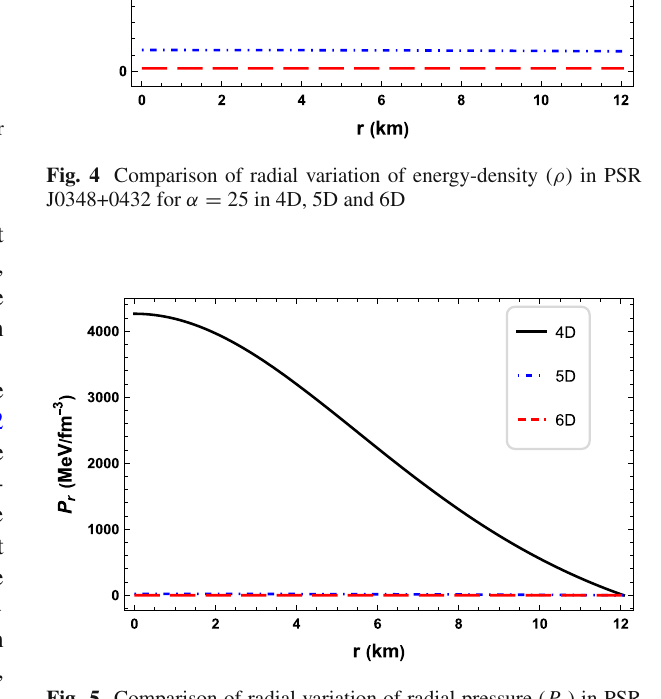
increases, the central density and the radial pressure of the star decreases for a star with given mass and